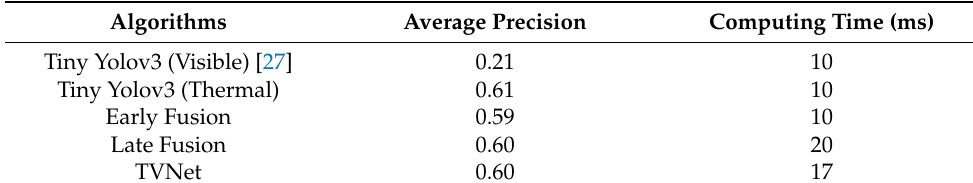
Table 5. Comparative Analysis of the TVNet on the nighttime subset.